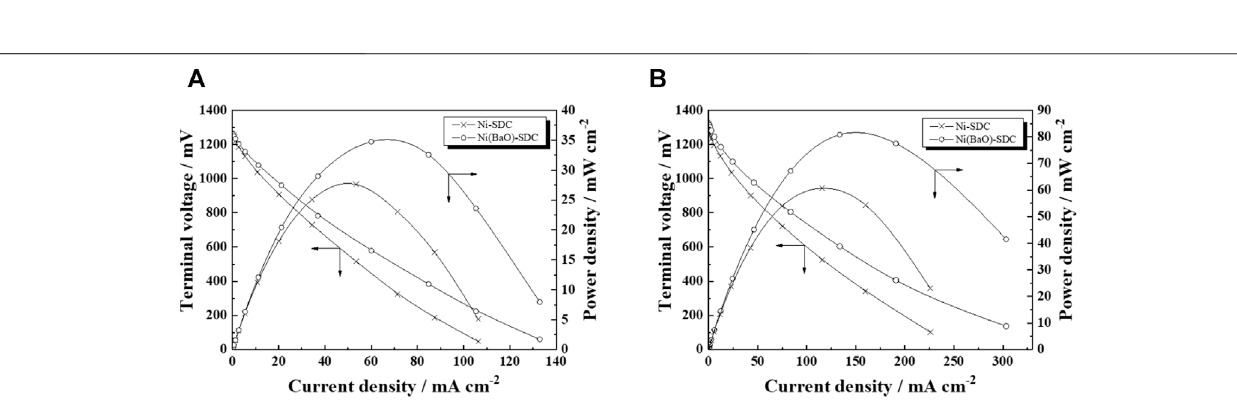
FIGURE 3 | XRD patterns of anode powders before (A) and after (B) H 2 reduction. The SDC powder (A) was calcined at 350 ° C, and Ni/SDC and Ni(BaO)/SDC powders were fi red at 700 ° C. The powders (B) were subsequently reduced in H 2 at 700 ° C.